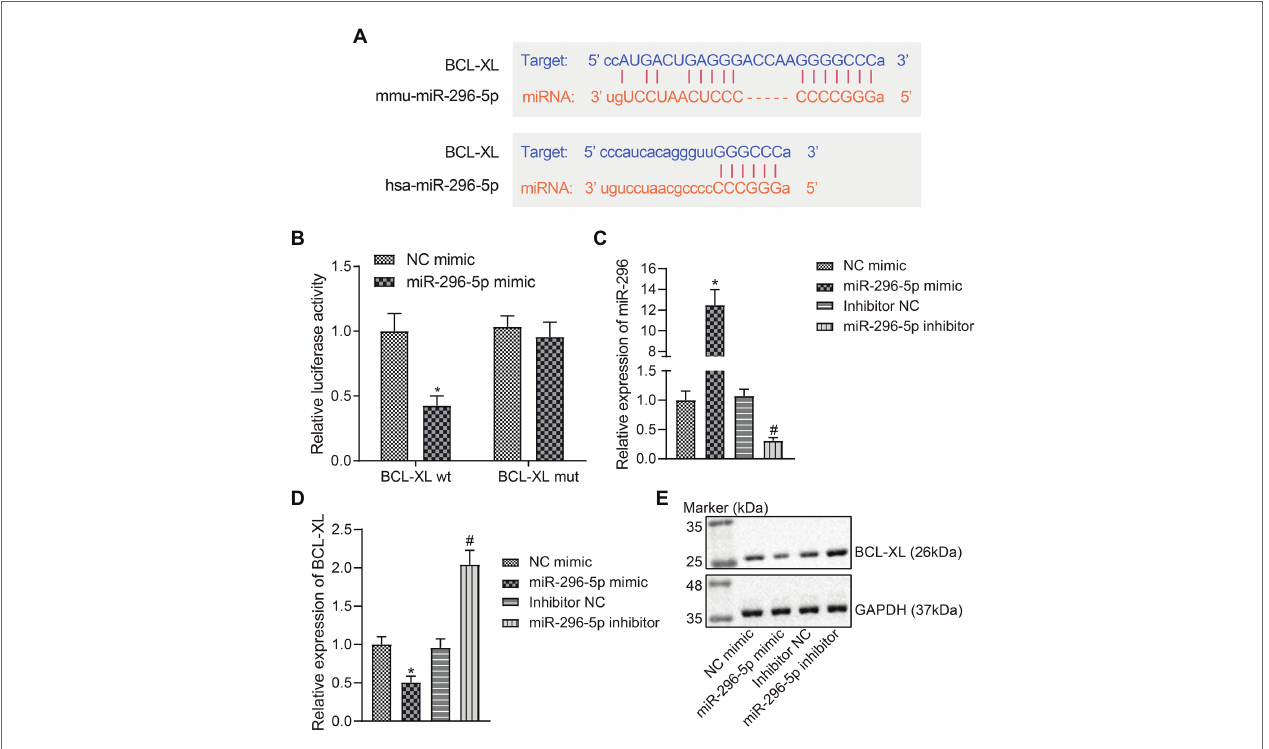
FIGURE 2 | miR-296-5p directly targets Bcl-xl . (A) The binding site of hsa- miR-296-5p and Bcl-xl 3 ' -UTR predicted by Starbase software. (B) The luciferase activity of Bcl-xl in 293 T cells transfected with miR-296-5p mimic or NC mimic. (C) The expression of miR-296-5p in lymphocytes determined by RT-qPCR. (D) The mRNA expression of Bcl-xl in lymphocyte series determined by RT-qPCR. (E) The protein expression of BCL-XL normalized to GAPDH in lymphocyte series determined by Western blot assay. * p < 0.05 compared with cells transfected with NC mimic, # p < 0.05 compared with cells transfected with inhibitor NC. The results were measurement data and expressed as mean ± standard deviation, and data comparison between two groups was performed using an unpaired sample t -test. The cell experiment was repeated three times